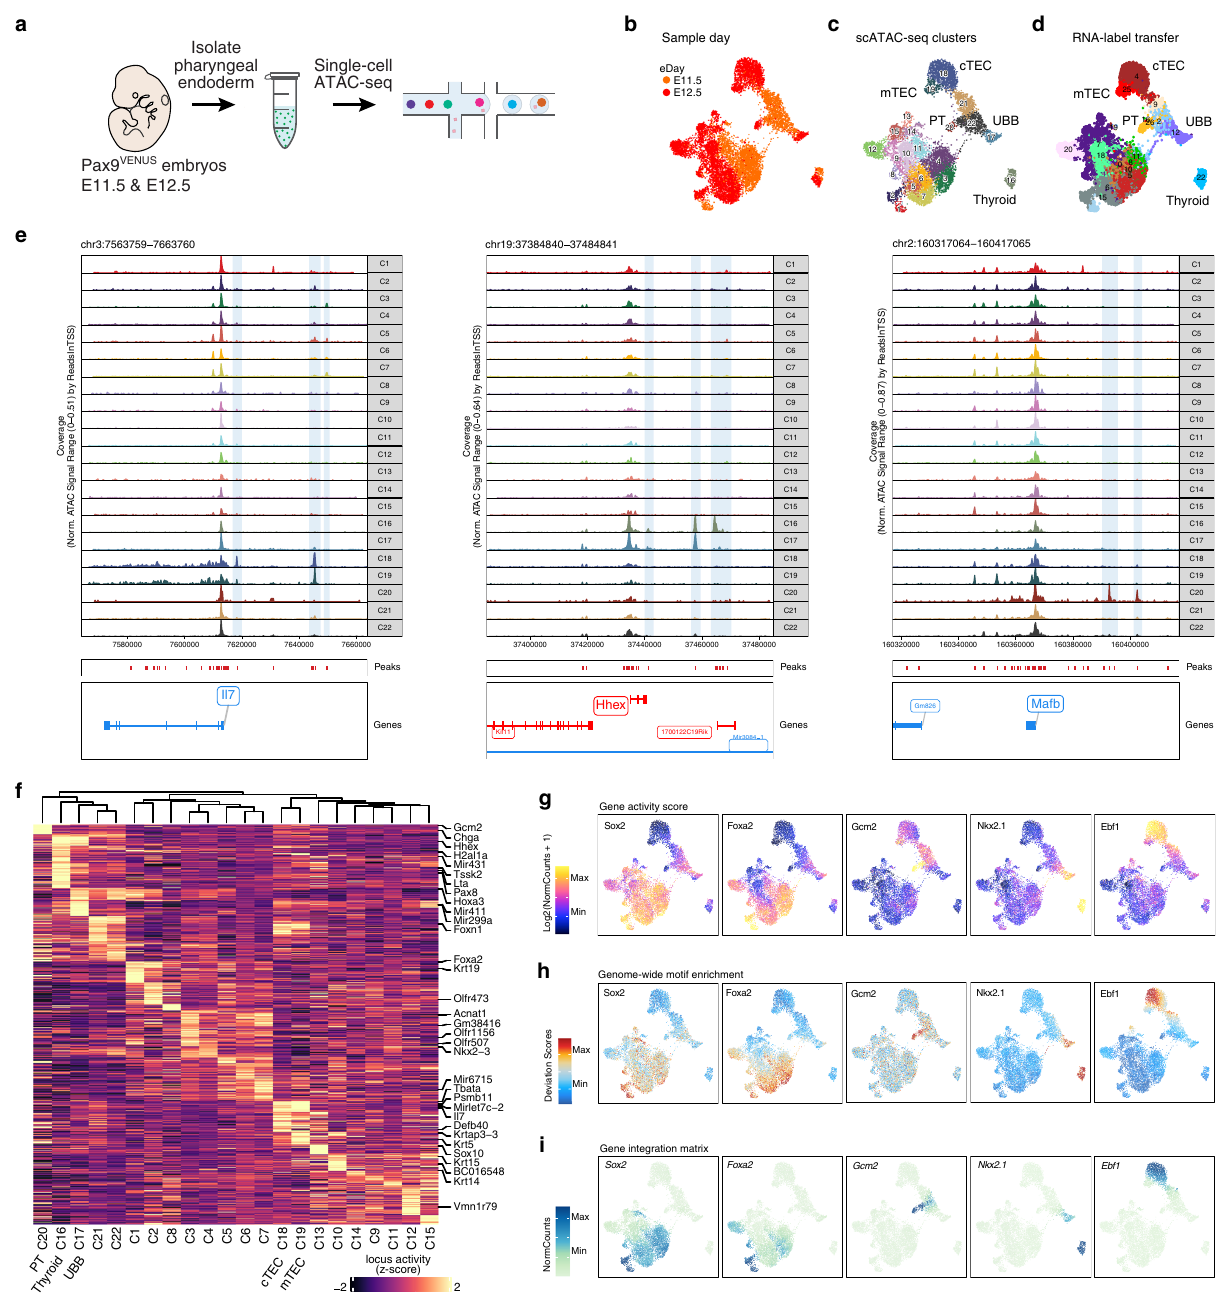
Fig. 2 Single-cell chromatin map of developing mouse pharyngeal endoderm during early organogenesis. a Experimental work fl ow schematic. Single cells were prepared as described in Fig. 1a from E11.5 ( n = 2) and E12.5 ( n = 2) Pax9 VENUS embryos. Single-cell chromatin landscapes were captured and barcoded using Chromium Single-cell ATAC Reagents. b – d UMAP visualization of pharyngeal endoderm early organogenesis chromatin accessibility dataset ( n = 10,890 cells) colored by embryonic day ( b ), Louvain clusters ( c ), and scRNA label transfer (see Supplementary Fig. 3 for cluster color labels) ( d ). Each dot represents one cell in the global chromatin accessibility space. cTEC, cortical thymic epithelial cells; mTEC, medullary thymic epithelial cells; PT, parathyroid; UBB, ultimobranchial body. e Normalized genome browser tracks of three tissue-speci fi c loci ( Il7, Hhex , and Mafb ) highlighting annotated peaks. Each track displays pseudobulk ATAC data aggregated and colored by Louvain cluster from ( c ). f Heatmap of differential ( p -value ≤ 0.1, log2-fold change ≥ 0.5) cluster-speci fi c predicted gene expression (ArchR gene score) of the top 50 genes per cluster, row z-scored with clusters ordered by unsupervised hierarchical clustering. g – i Tissue-speci fi c TF activity through gene activity score ( g ), genome-wide motif enrichment ( h ) and, inferred RNA expression based on the gene integration matrix ( i